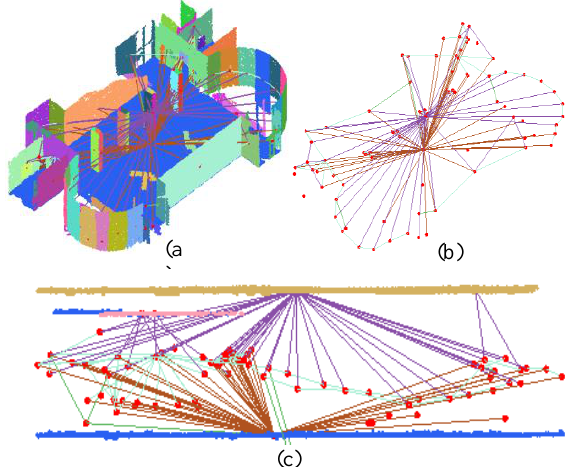
Figure 6. (a) Shows surfaces with connected edges. (b) Shows edges and nodes of the graph. Each node is representing a surface. (c) Shows the floor and ceiling surfaces and edges of the graph. Three different colors of edges representing three types of connection for wallwall (cyan), wallceiling (purple) and wallfloor